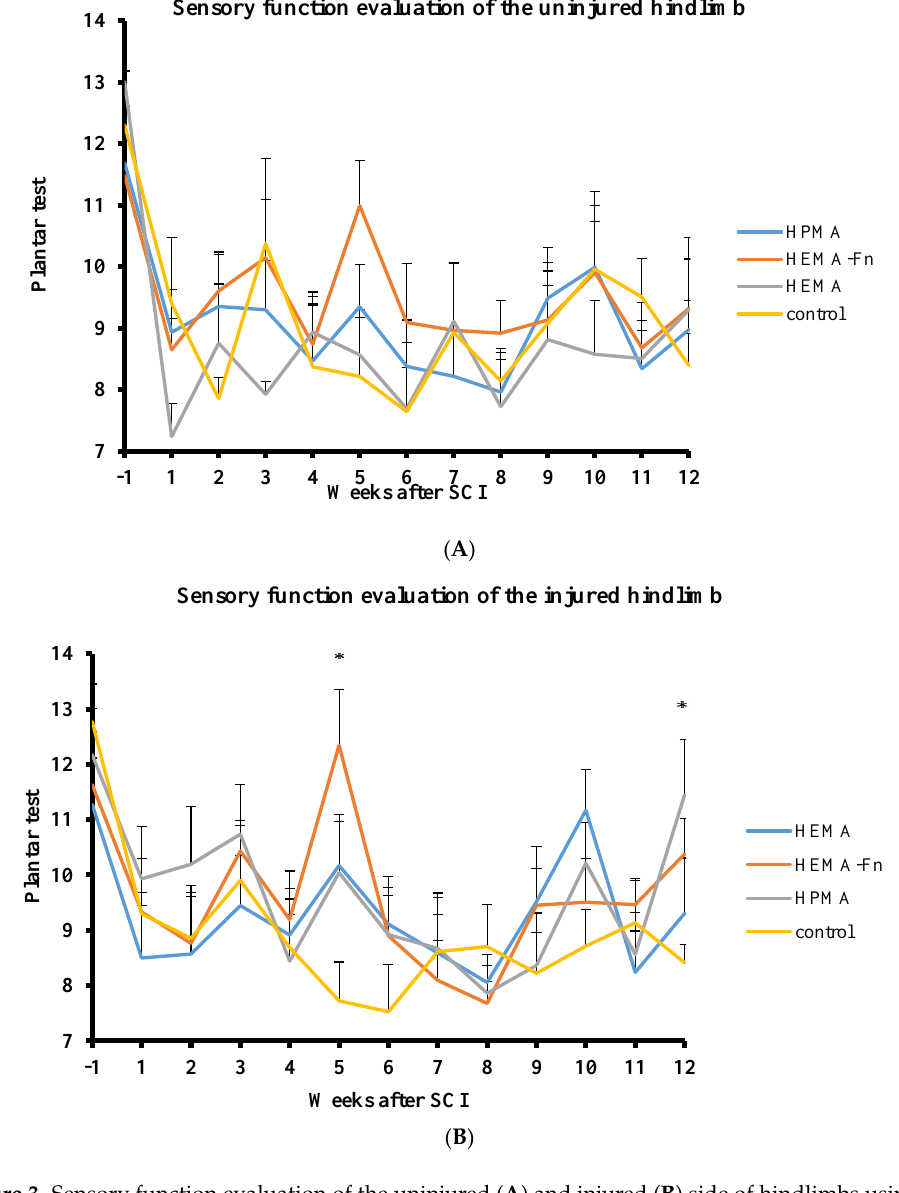
Figure 3. Sensory function evaluation of the uninjured ( A ) and injured ( B ) side of hindlimbs using the plantar test. There were statistically significant differences in the sensory response between rats treated with 2-hydroxyethylmethacrylate (HEMA)-Fn and the control group on week 5 and then between the HPMA and both the HEMA and the control group on week 12 (* p < 0.05). The data represent mean values and error bars represent